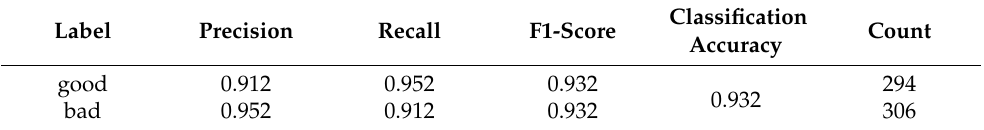
Table 5. Classification report of LoGit with subset of not previously seen images.